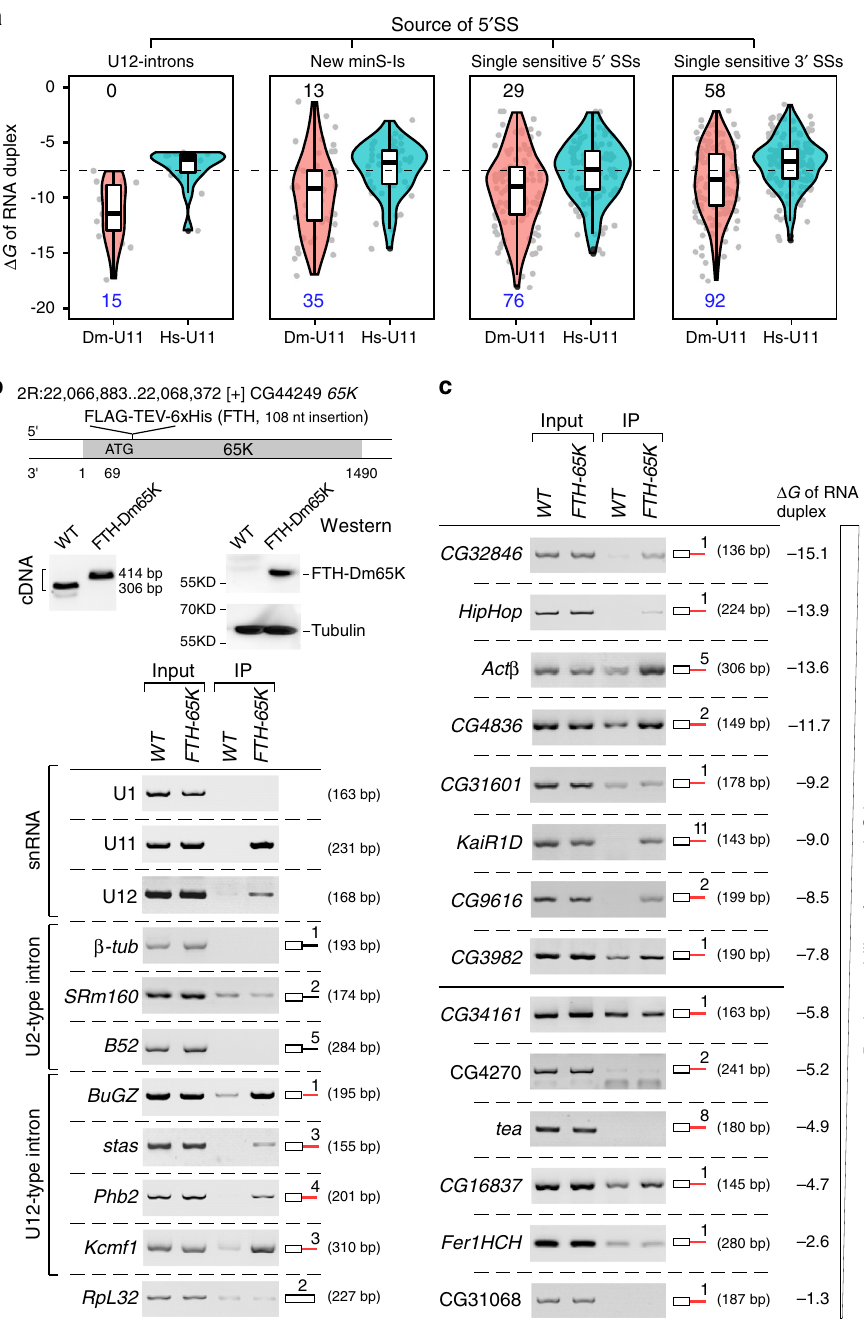
Fig. 5 Association of new minS-Is with minor-spliceosomal components. a Predicted stability of RNA duplexes formed by the 5 ′ SS of minS-Is and U11 snRNA. Potential base-pairs and free energy are calculated by RNAduplex ; both Drosophila and human U11 snRNAs are used for duplex analyses. n = 15 (U12 intron); n = 48 (new minS-Is); n = 105 (single sensitive 5 ′ SSs); n = 150 (single sensitive 3 ′ SSs). b Dm65K is a speci fi c component of the minor spliceosome. The FTH-Dm65K strain constructed using the CRISPR/Cas9 system is validated by PCR, sequencing, and western blot (upper). FTH-Dm65K enriches minor snRNAs and U12-type introns, but not major snRNA or U2-type introns (lower). Co-puri fi cations were performed using lysate from the WT and FTH-Dm65K Drosophila strains. c Association of new minS-Is with Dm65K. FTH-Dm65K enriches pre-mRNA of most new minS-Is that contain 5 ′ SS predicted to form a stable duplex with U11 snRNA. minS-Is (red line) and free energy ( Δ G ) are indicated. In ( a ) boxplots, the middle line show data median, the lower and upper hinges correspond to the 25th and 75th percentiles, the upper whisker extends from the hinge to the largest value no further than 1.5 × IQR from the hinge (where IQR is the interquartile range) and the lower whisker extends from the hinge to the smallest value at most 1.5 × IQR of the hinge. Source data are provided as a Source Data fi